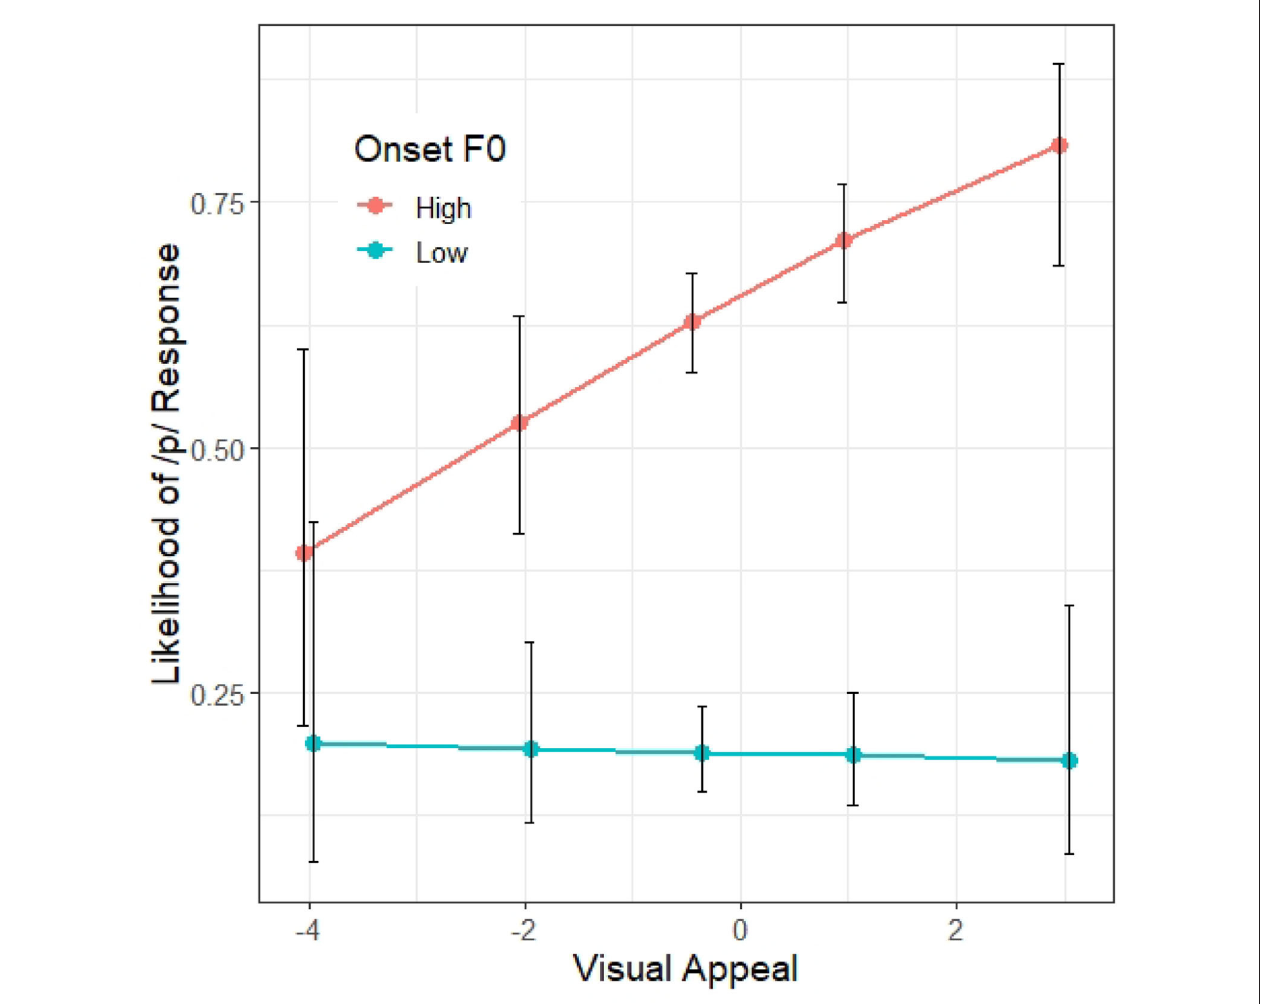
FIGURE 6 | Model 2 predictions of the probability of a /p/ response (y axis) in different F0 onset conditions according to the talker’s visual appeal (x axis). The error bars indicate 95% confidence